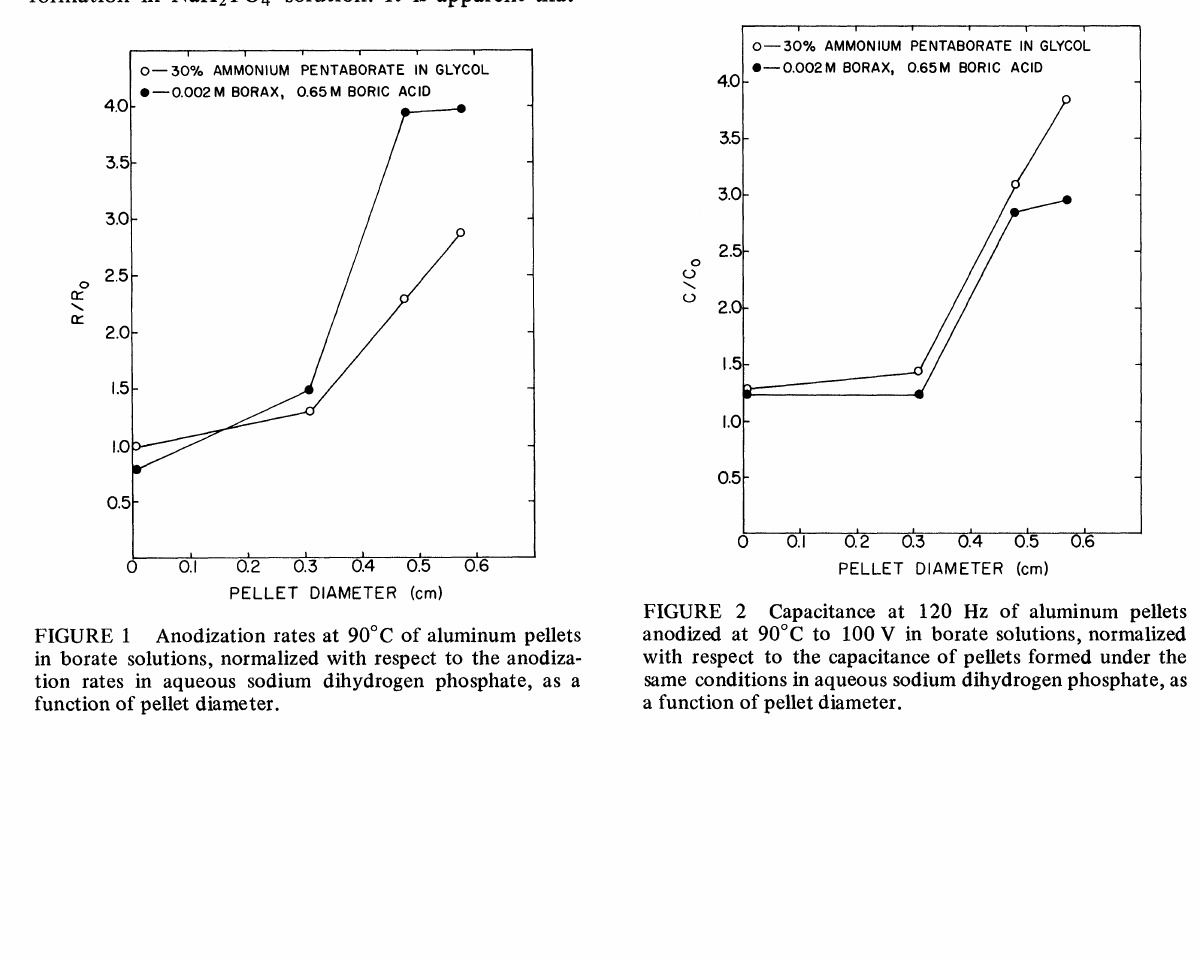
the deviation from ’normal’ formation behavior- defined by the data for foil, and plotted at the zero-diameter line- increases with increasing pellet